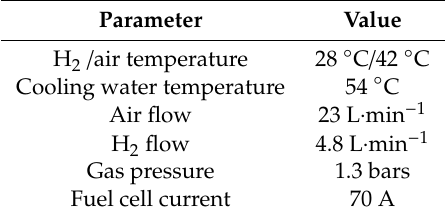
Figure 1. Aging test of PEMFC stack. ( a ) PEMFC stack test bench [20]; ( b ) Cells voltages during the test. Figure 1 . Aging test of PEMFC stack. (a) PEMFC stack test bench [20]; (b) Cells voltages during the test. Table 1. Proton exchange membrane fuel (PEMFC) operating